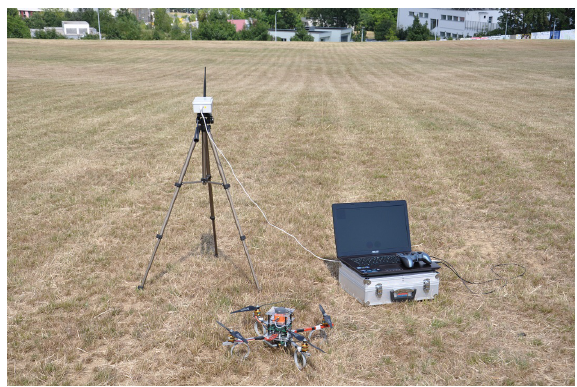
Figure 7. Base station and Uranus UAV.